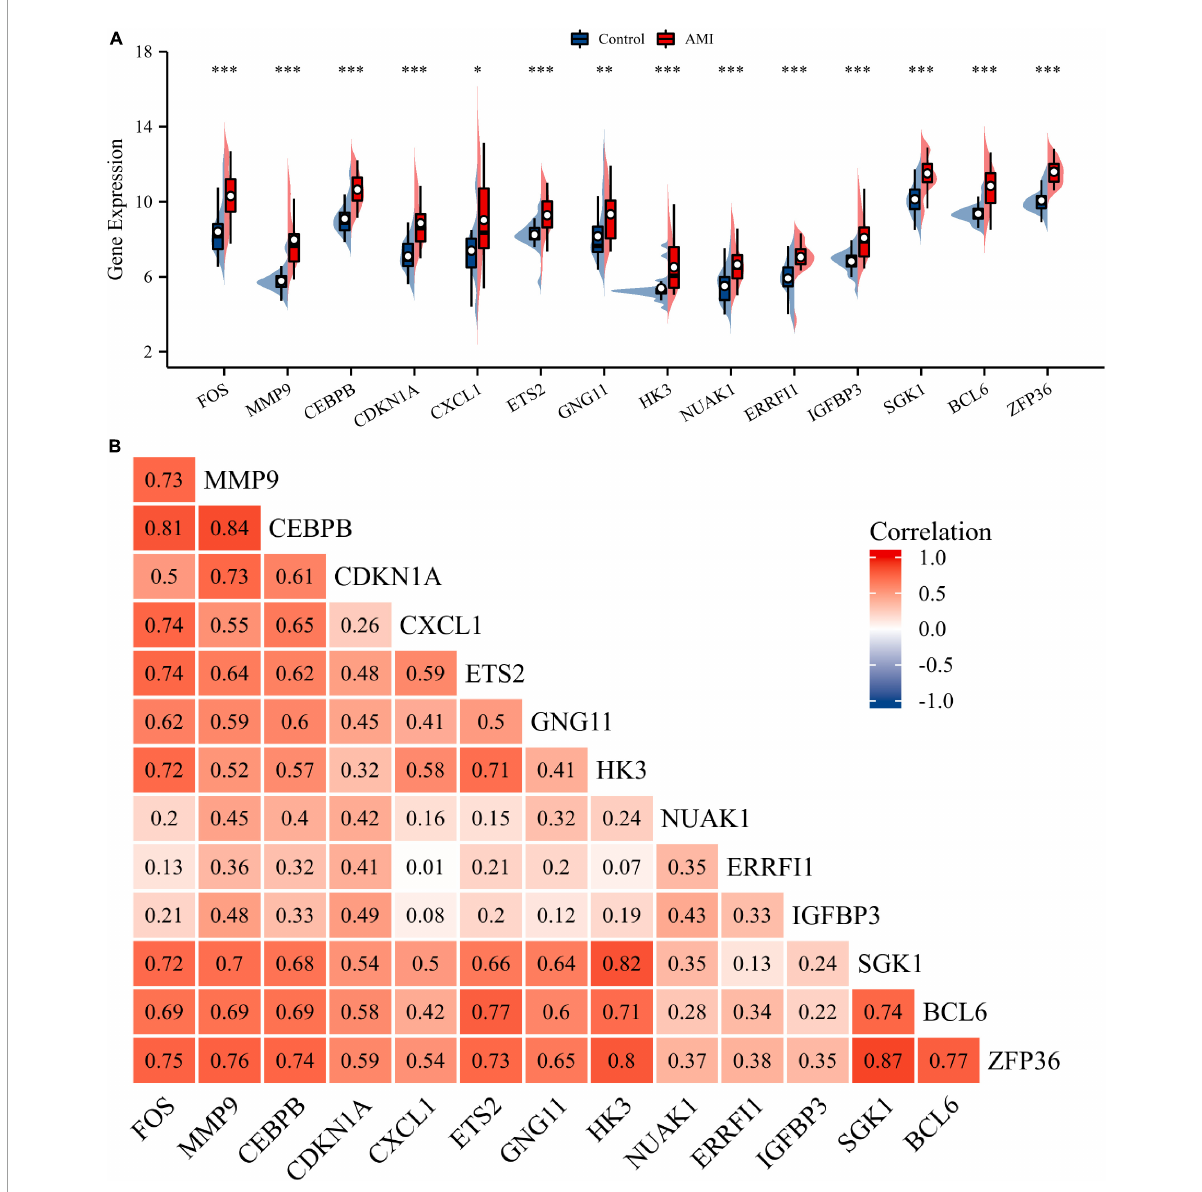
FIGURE4 Expression and correlation analysis of 14 DESRGs. (A) Expression levels of DESRGs in the AMI and control samples in the GSE66360 training set were visualized by box plot. ∗ p < 0.05, ∗∗ p < 0.01, ∗∗∗ p < 0.001. (B) Spearman correlation among 14 DESRGs. AMI, acute myocardial infarction; DESRGs, differentially expressed senescence-related